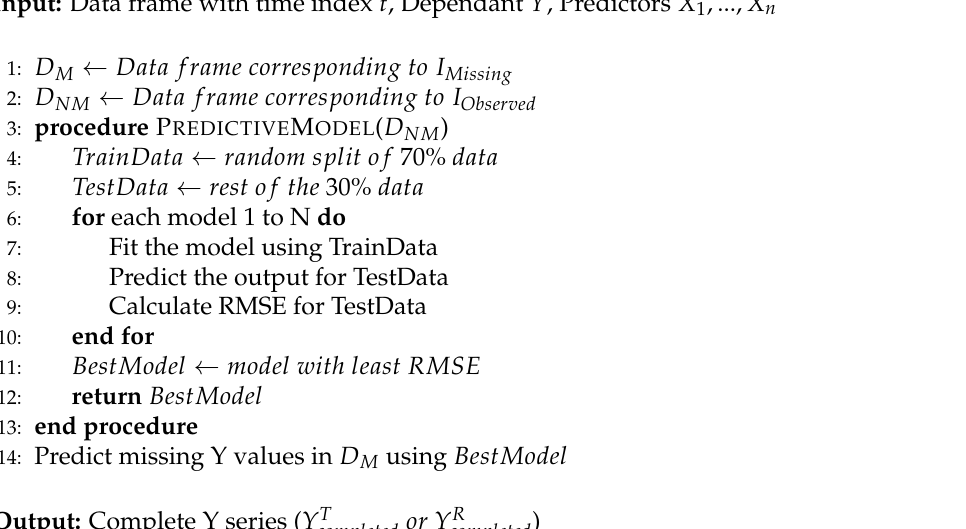
Algorithm 2 Imputing Trend/Random